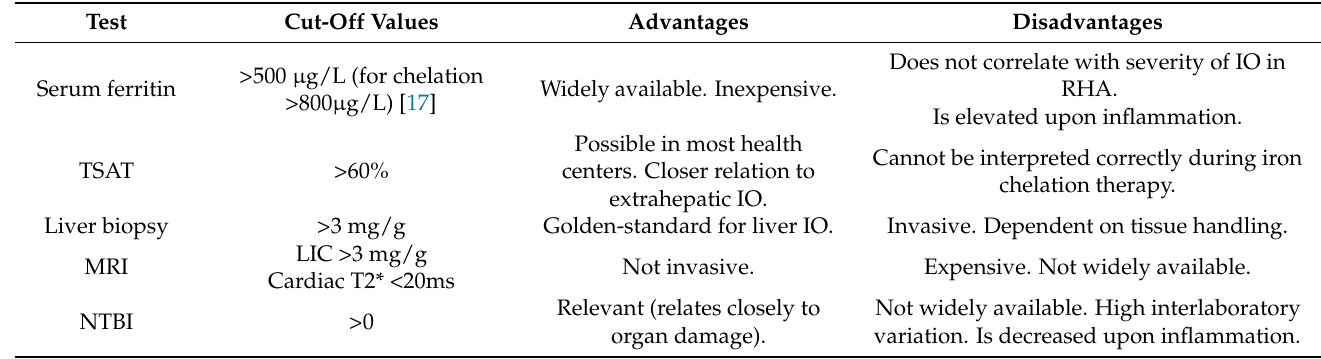
Table 1. Overview of diagnostic tools in assessment of iron overload. Iron overload (IO), liver iron content (LIC), magnetic resonance imaging (MRI), non-transferrin bound iron (NTBI), rare hereditary anemia (RHA), Transferrin saturation